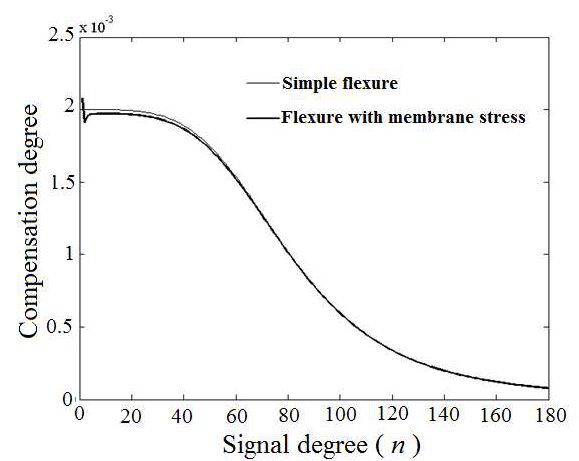
Figure 1: Compensation degree C n according to simple flexure model, Eq. (2i) and flexure model considering membrane stress, Eq. (3c). T 0 = 33 km and T e = 28